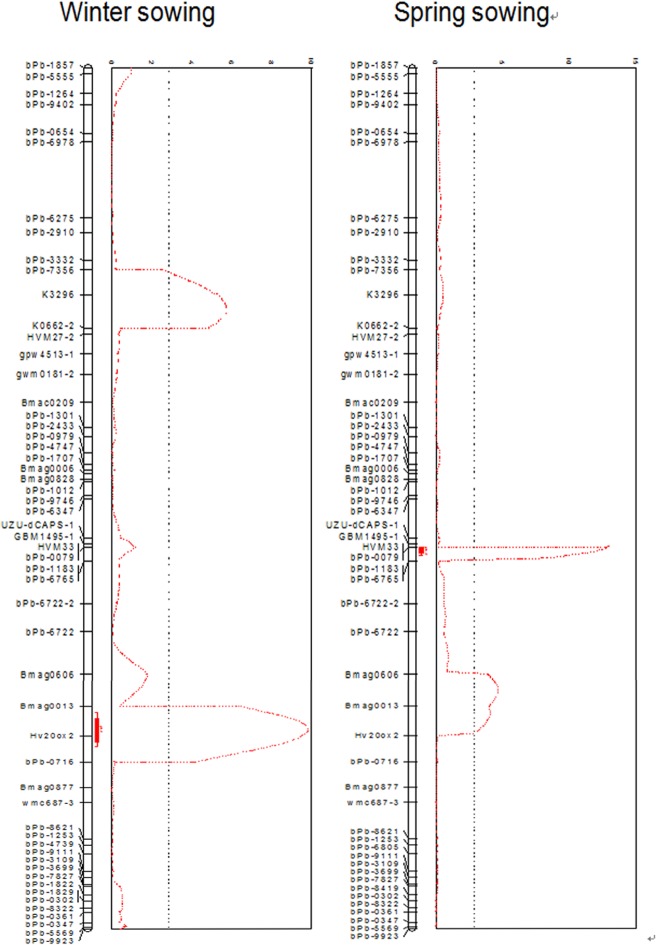
Diagnostic markers developed from the uzu and sdw1 sequences were mapped on barley chromosome 3H.The linkage maps were constructed using Joinmap4.0, QTLs were detected in a composite interval mapping using MapQTL5.0. The diagnostic markers co-segregated with QTLs representing the dwarfing genes in the ‘TX9425/Franklin’ doubled haploid population, with a third QTL identified and located on chromosome 3HS.